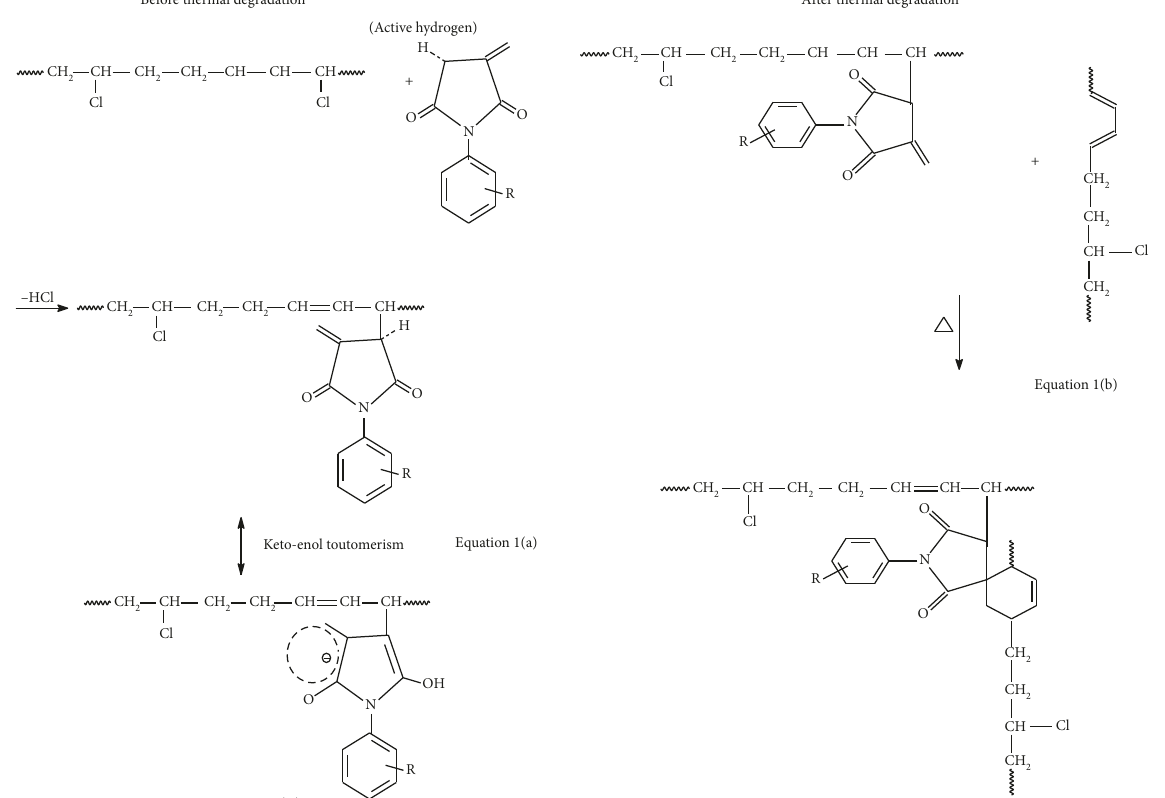
Scheme 1: Suggested reaction mechanism representing the modification of poly(vinyl chloride) by N -phenyl itaconimide derivatives, before and after exposure to molding temperature 180 ° C, in air.